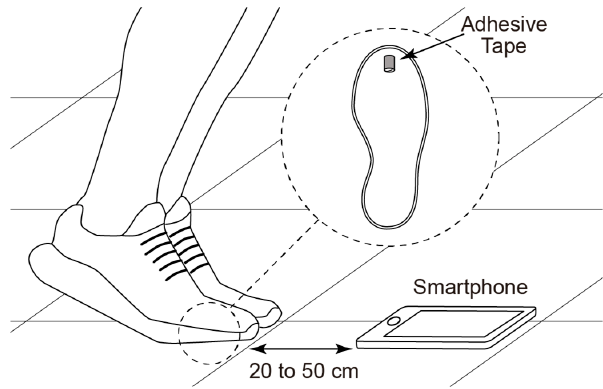
Figure 1. Experimental setup of jump recordings with the microphone of a smartphone.